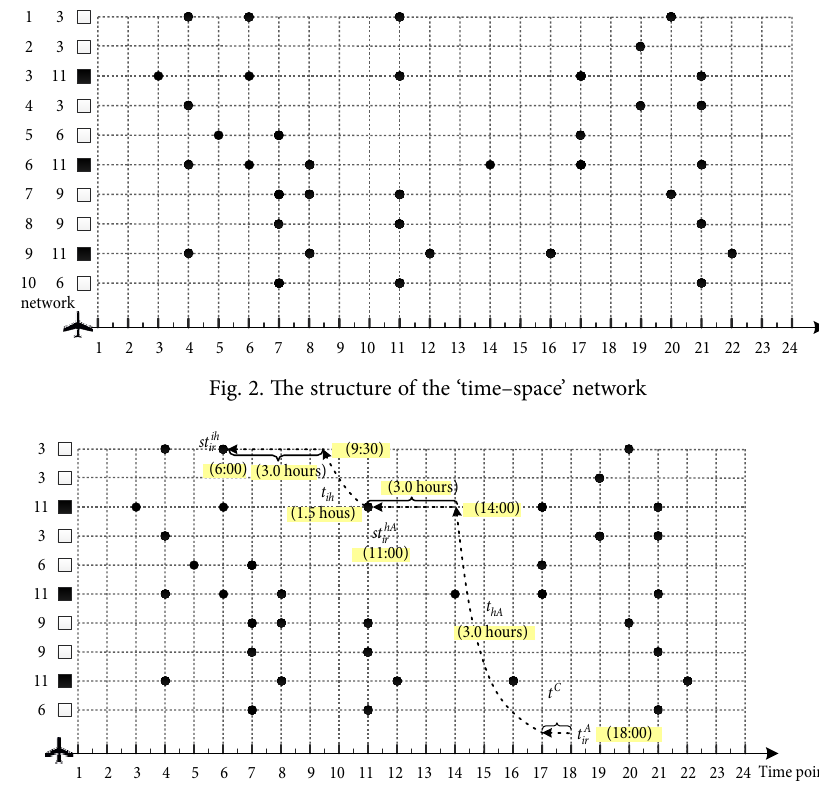
Fig. 3. The decision process of the departure time in the trip chain